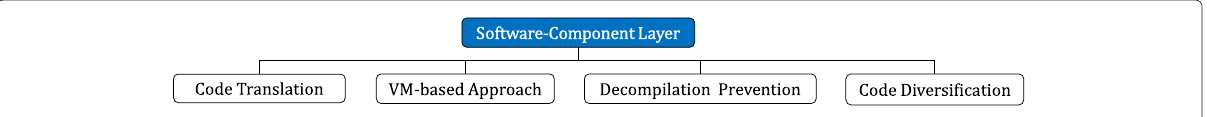
Fig. 7 The obfuscation techniques of software-component